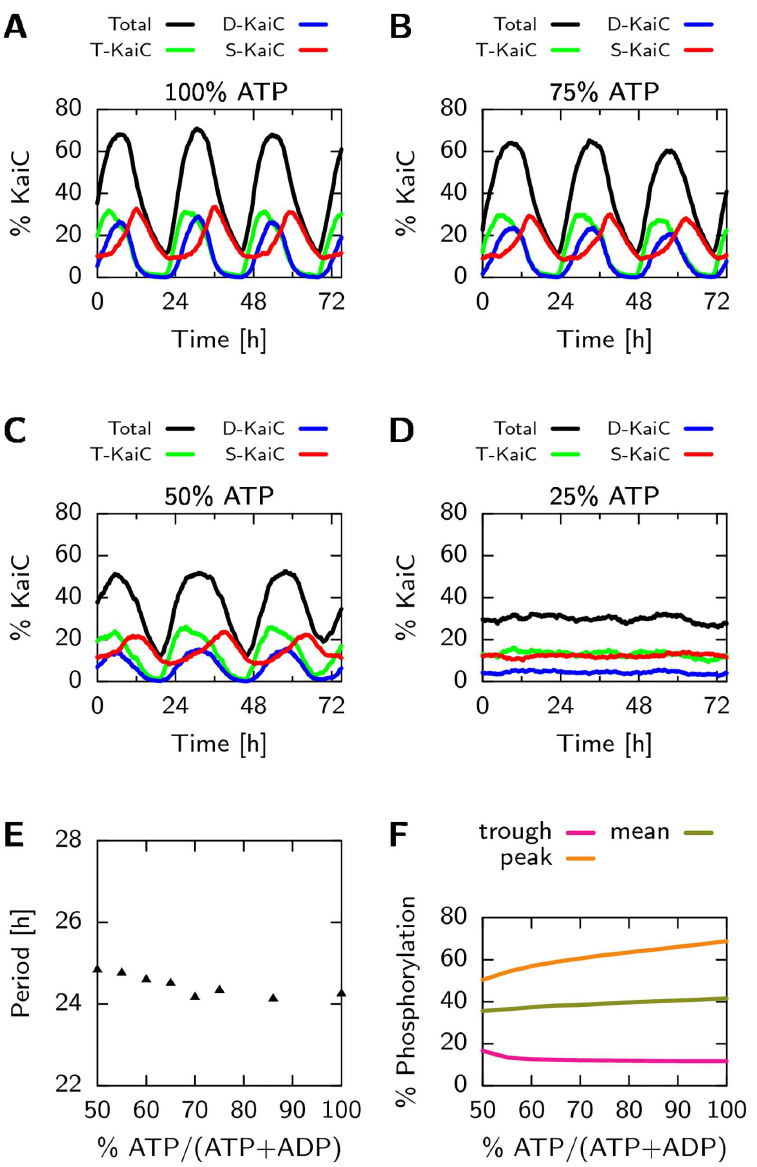
Fig 10. The Kai systemoscillates over a wide range of ATP fractions, while the period remains unchanged. (A-D) Time traces of monomers in the T state (green), D state (blue), S state (red) and total phosphorylation level (black), for different ATP fractions in the bulk. Amplitudesand phases in good agreement with experiment(Compare with [27], S1 Fig), except that our system does not oscillateat 25% ATP fractions. (E) The averagepeak-to-peaktime of the phosphorylation fraction for a 1000 hour time trace at different ATP fractions. The periodis remarkably unaffectedby the ATP fraction, even though it has a big influenceon the phosphorylation speed, as we showedin Fig 6D. (F) Mean peak and trough phosphorylation levels at different ATP fractions. The increase in peak-hight with α ATP is in in good agreement with experiment. However, in our simulations, the level of the trough is almost independent of α ATP , while in experiments it increaseswith α ATP (Comparewith Fig. S6 in [53] and Fig. 1 in